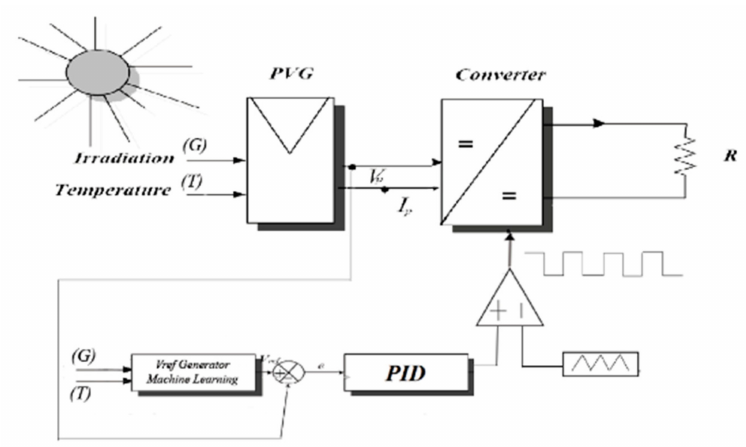
Figure 1. Proposed maximum power point tracking (MPPT) system.